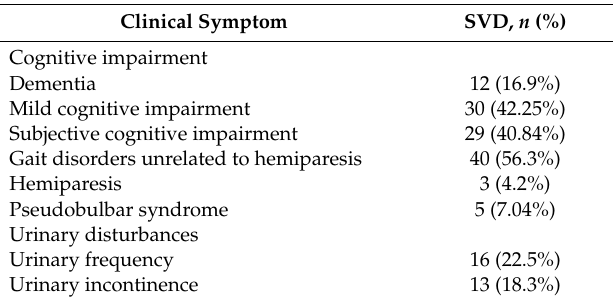
Table 2. Clinical symptoms in patients with SVD.